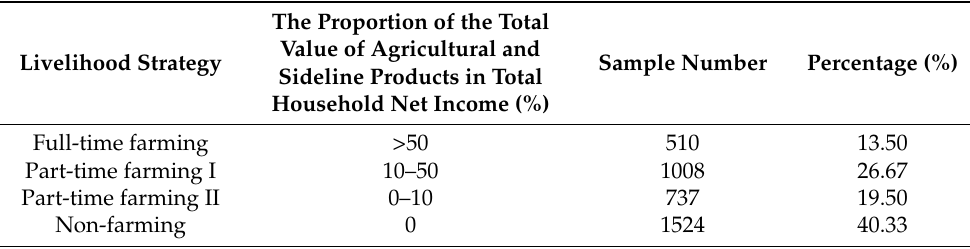
Table 4. Classification of household livelihood